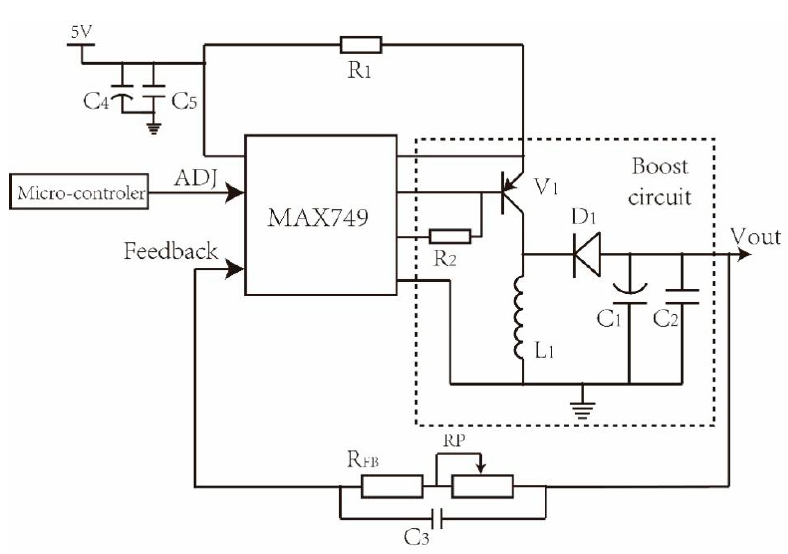
Figure 2. Schematic of programmable negative voltage generator.